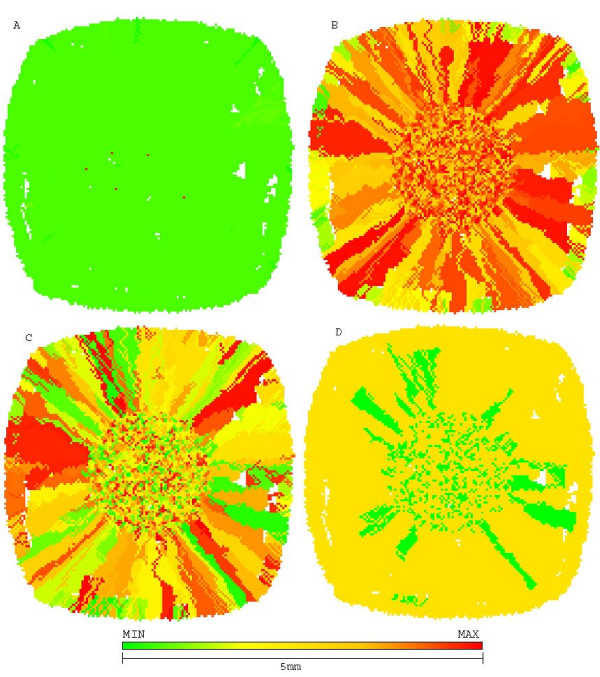
Growth pattern of untreated tumor at generation 39. A shows chemosensitive cells (green) and chemoresistant cells (red). B shows distribution of glycolytic phenotype: cells closer to green have slower metabolic rate and those closer to red are more glucose avid. C shows distribution of acid resistance, the closer to red the more resistant and the ones closer to green are more sensitive to low pHe. D shows cells in low pHe induced quiescent state in green and proliferative cells in yellow.